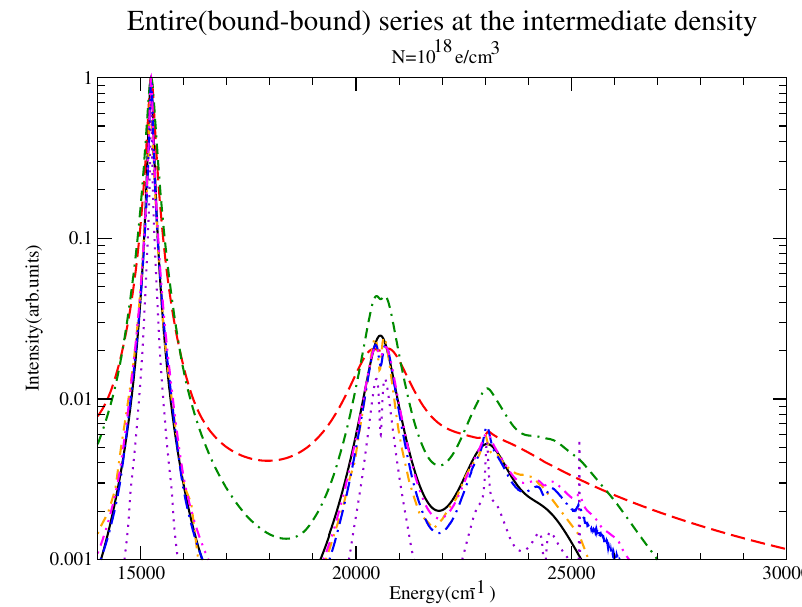
Figure 14. The entire series for the intermediate density considered for QC-FFM (solid black), PPP (dashed red), DWE (dash-dotted orange), CONVST without strong collisions (dotted violet), CONVST with strong collisions (dot-double dashed green), CONVPST without strong collisions (long dash-dotted blue) and CONVPST with strong collisions (dash-double dotted magenta).